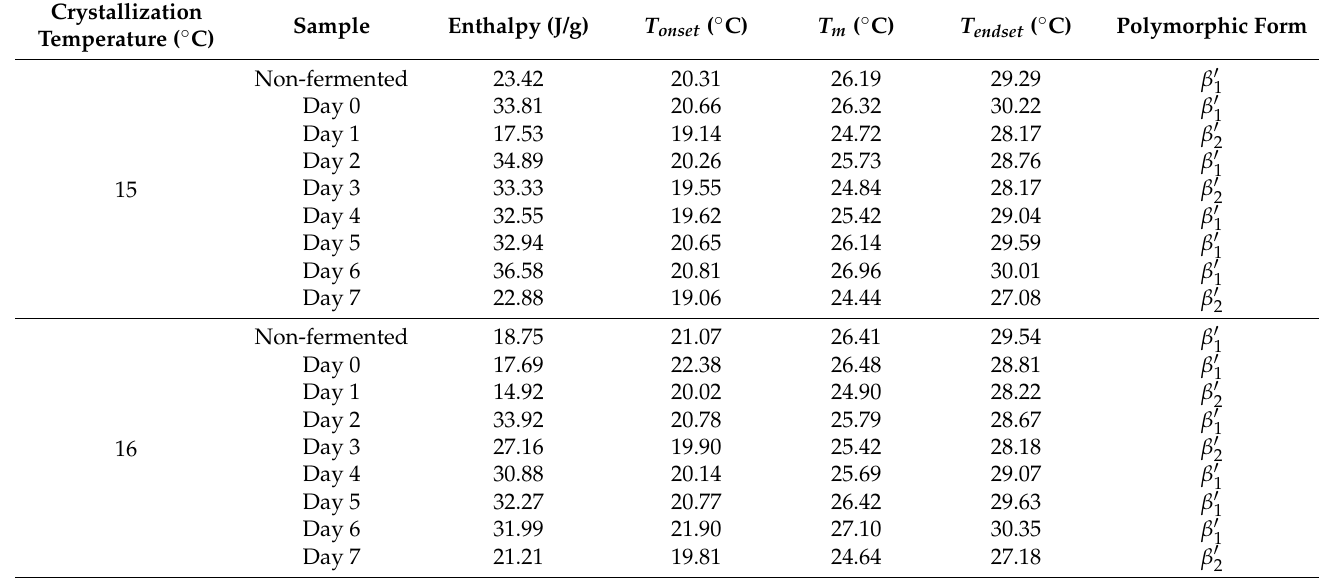
Table 6. Polymorphism of CB inside cocoa beans during spontaneous